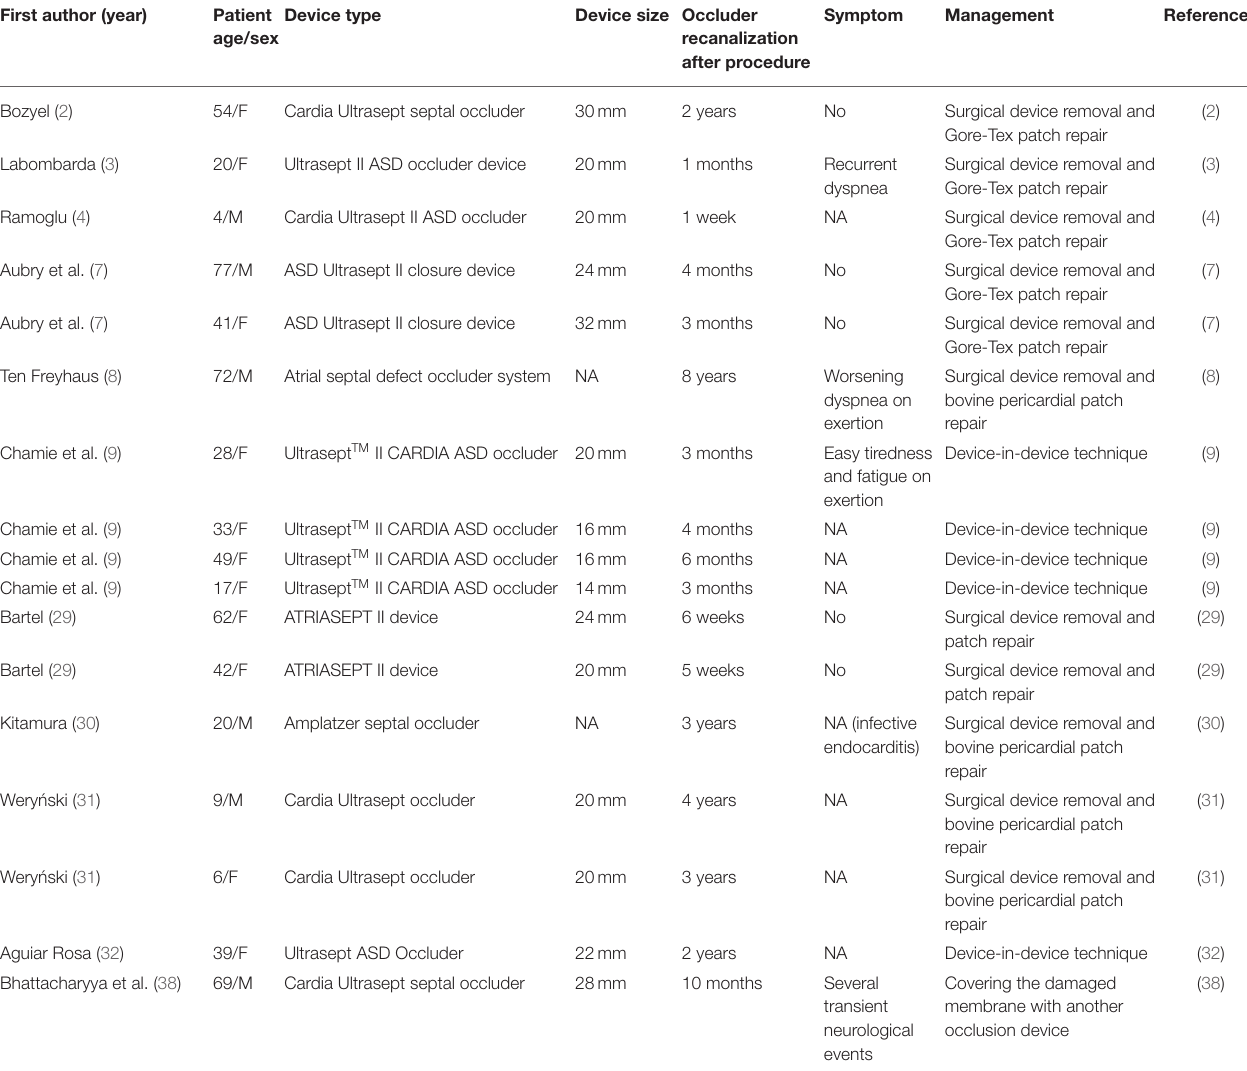
TABLE 1 | Summary of reported cases of polyvinyl alcohol membrane perforation of atrial septal